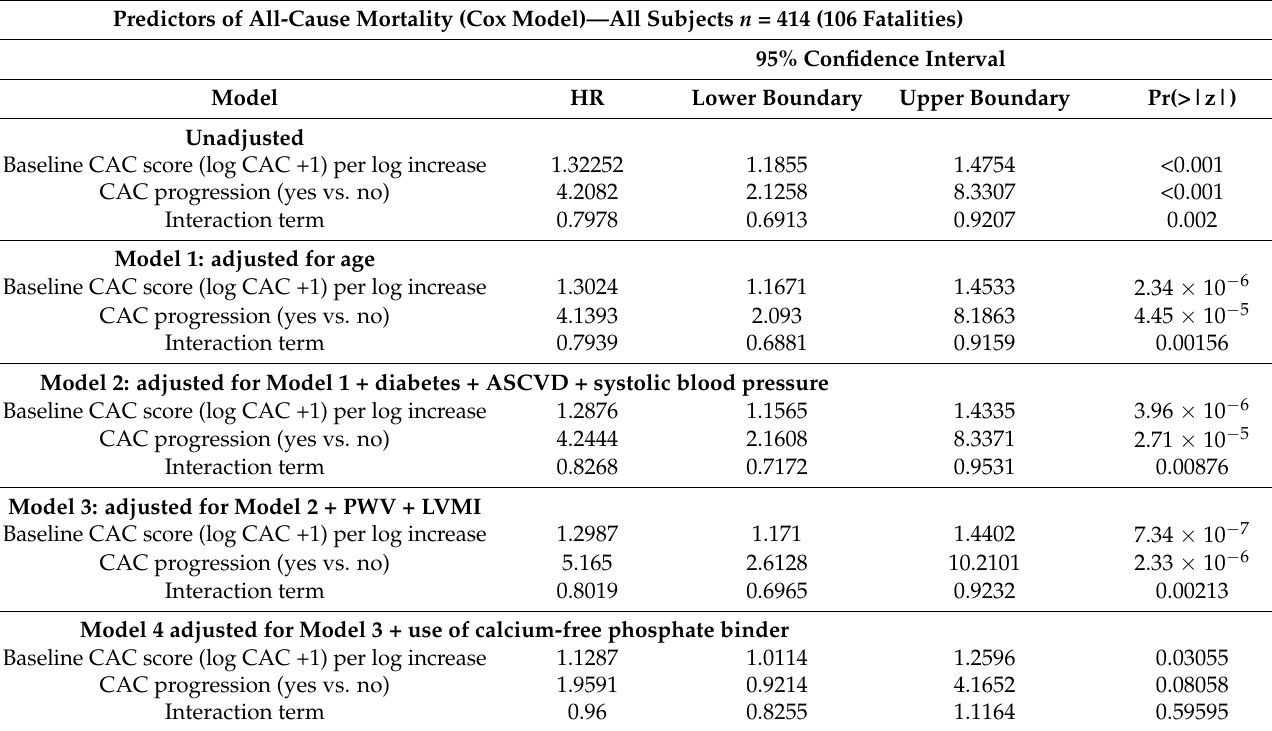
Table 3. Predictors of all-cause mortality in the overall study cohort.